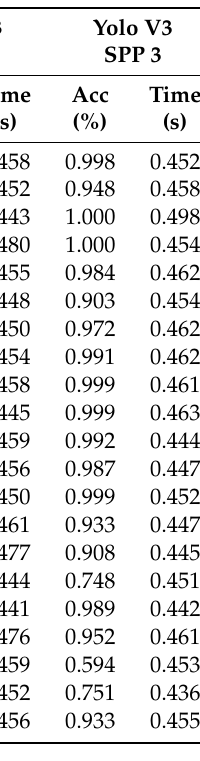
Table 4. The testing performance of the